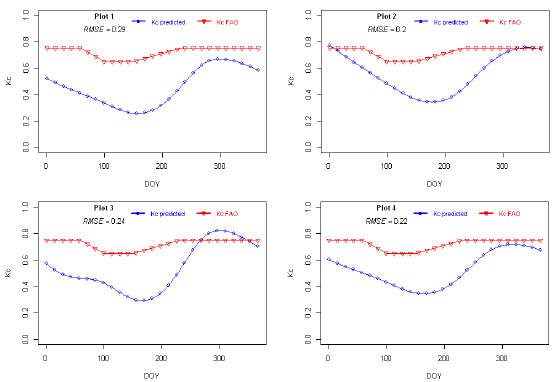
Figure 7. Predicted and FAO Kc curves for selected citrus plots